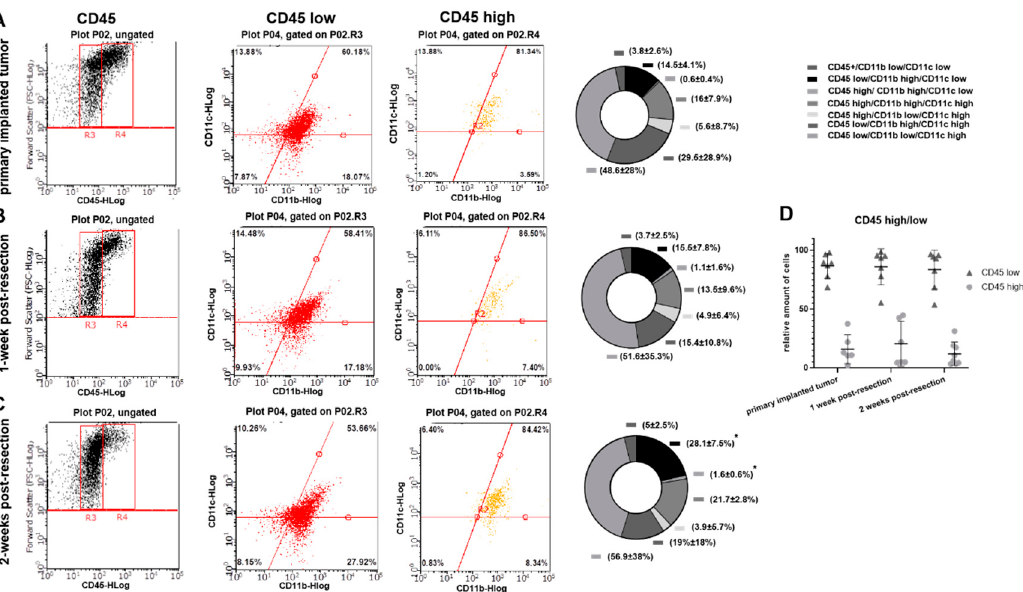
Figure 4. Flow-cytometric analysis of myeloid cells in primary implanted tumors and tumors 1- and 2-weeks post-resection in the GL261-C57BL/6 mouse glioma implantation model. ( A – C ) The left column contains forward scatter (FSC) vs. CD45 plots demonstrating CD45 populations: low (R3) and high (R4). The middle column contains CD11b + vs. C11c + events plotted from CD45 high and CD45 low populations. Graphs showing proportional composition of cellular subtypes are shown in the right column. ( D ) Calculation of CD45 high and CD45 low populations of microglia/macrophages purified from primary implanted tumors and tumors 1- and 2-weeks post-resection. Mean + S.D., and significant differences from the primary implanted tumor (* p < 0.005) are shown ( N = 6).